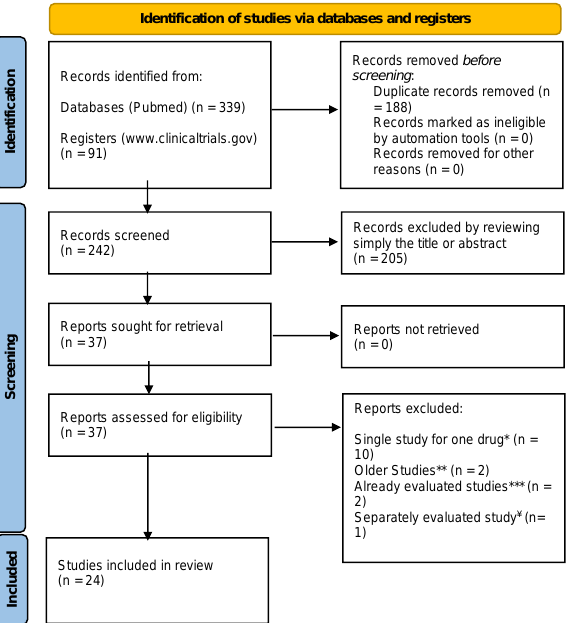
Figure 1. Strategy for collecting and evaluating clinical evidence for anti-obesity medicines in the context of this systematic review. PRISMA 2020 flow diagram for new systematic reviews, which included searches of databases and registers only. * GRADE cannot be applied in a single study;